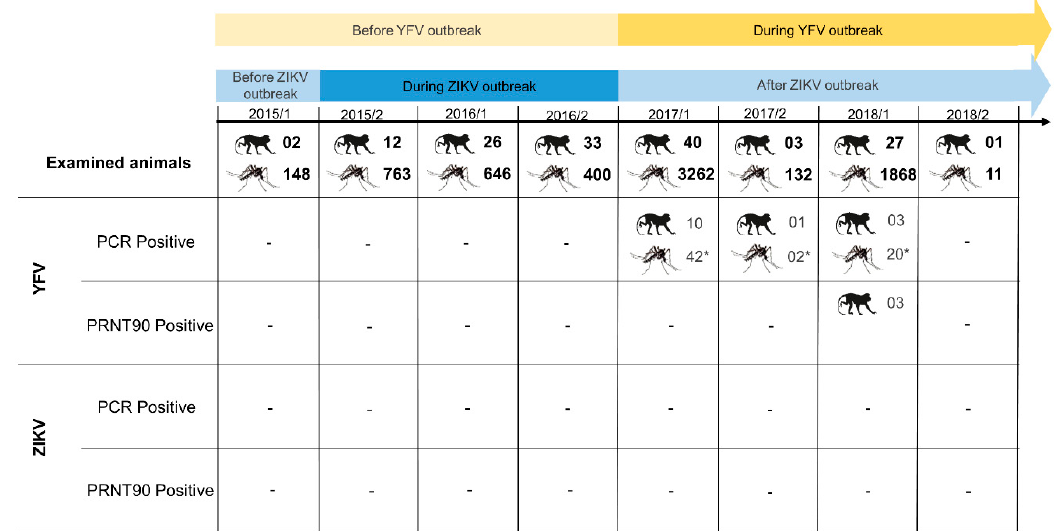
Figure 3. Number of examined and positive non-human primates and mosquitoes, according to epidemiological scenario, semester, year and diagnosis methods. Results of mosquito infections (*) are expressed in number of positive pools. Table 1. Mosquito species collected and screened through 94 arbovirus genotypes in four